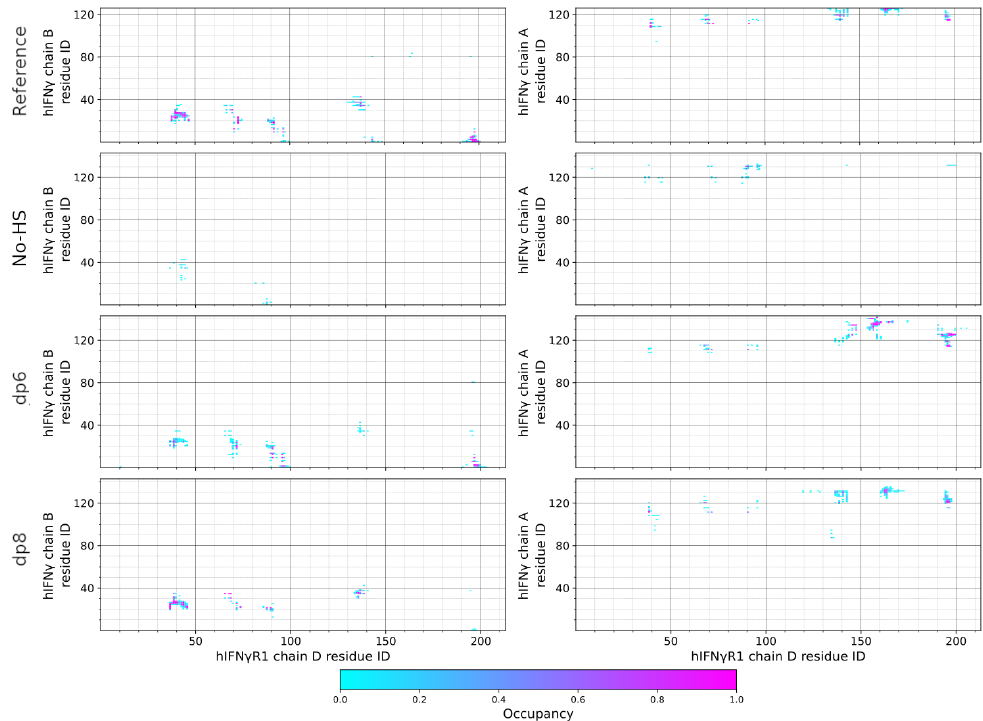
Figure 4. Contact maps between the two hIFN γ monomers (chain B and A) and receptor subunit